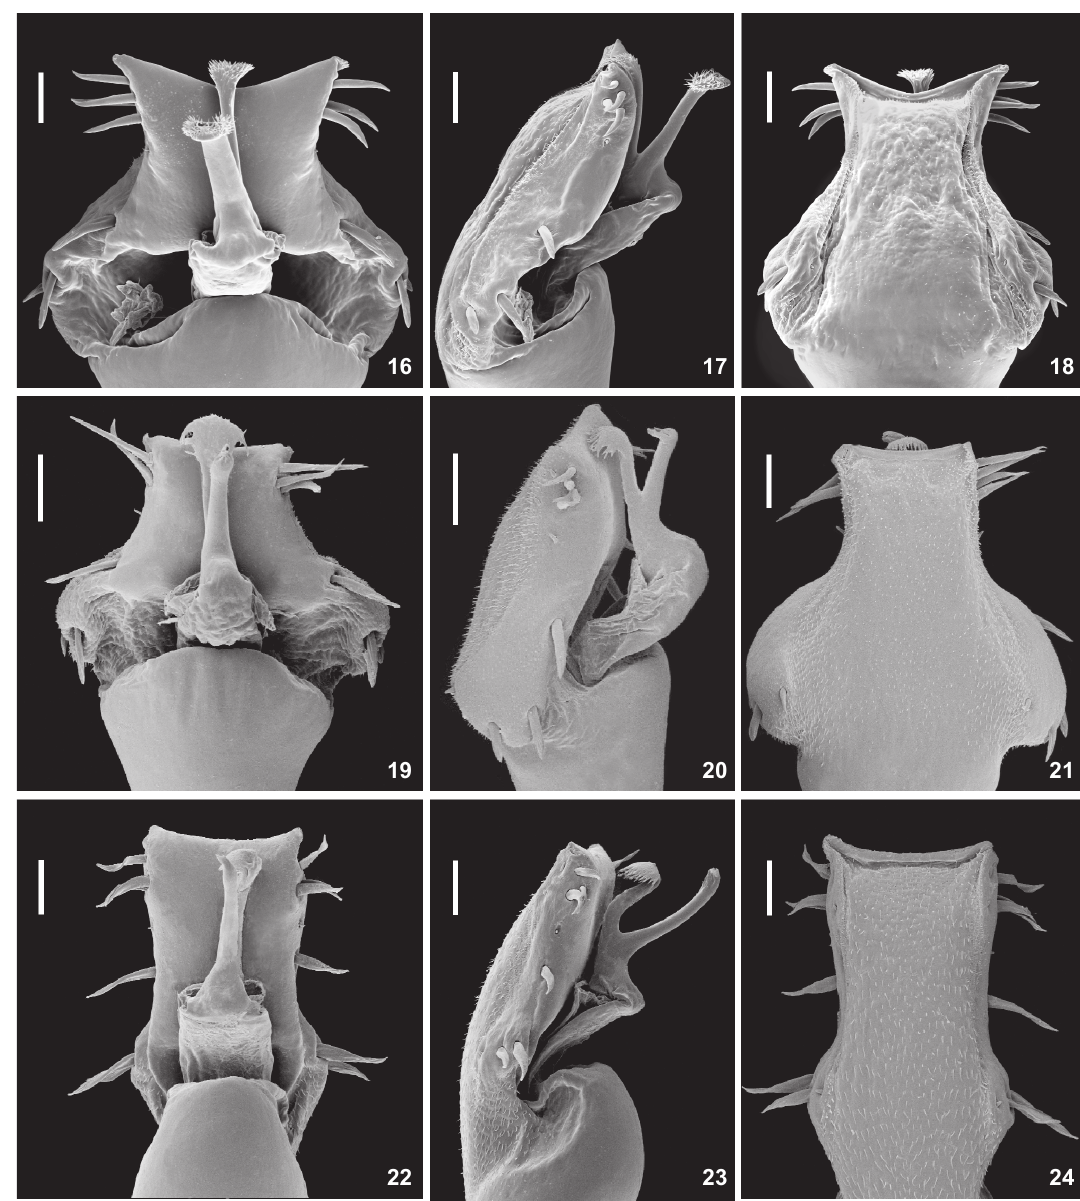
Figures 16-24. Distal part of Longiperna penis: (16-18) L. cancellata (MZSP 16322); (19-21) L. concolor (MZSP 17630); (22-24) L. coxalis (MZSP17655). Scale bar = 0.05 mm.